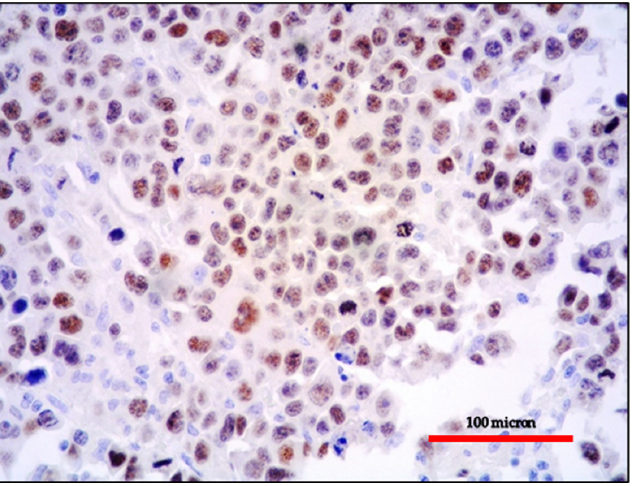
Figure 9. EC-PEL of the ileum: MYC protein expression is frequently found in EC-PEL despite the lack of MYC gene alterations (immunostaining, Ventana immunostainer, magnification 400 × ; original image from Prof Ascani).